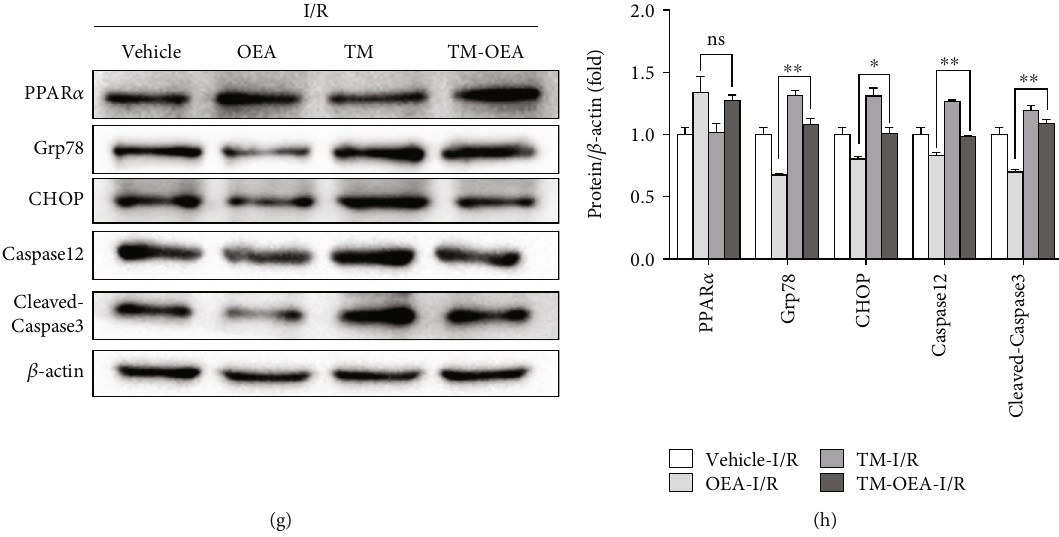
Figure 5: OEA inhibits ER stress-associated apoptosis to protect liver I/R injury. The mice were treated with TM by intraperitoneal (1 mg/ kg) for 24h, and OEA treatment was conducted for 1 h before the beginning of ischemia. The liver tissue and serum were harvested at 6h after reperfusion. TM treatment of HepG2 cells (1 μ g/ml) was conducted for 6 h, and OEA treatment (20 μ M) was conducted for 1 h before OGD/R. The proteins were harvested 6h after reoxygenation. (a and b) H&E staining and the percentage of necrotic area of the liver section. (c and d) Serum ALT/AST levels. (e and f) Western blotting analysis of PPAR α , Grp78, CHOP, Caspase12, and cleaved-Caspase3 expression after OEA or vehicle treatment. (g and h) TM administration for 24h before ischemia and harvest tissue protein at 6h after reperfusion. Western blotting analysis of PPAR α , Grp78, CHOP, Caspase12, and cleaved-Caspase3 expression alternation. ∗∗ p < 0 : 01 and ∗ p < 0 : 05